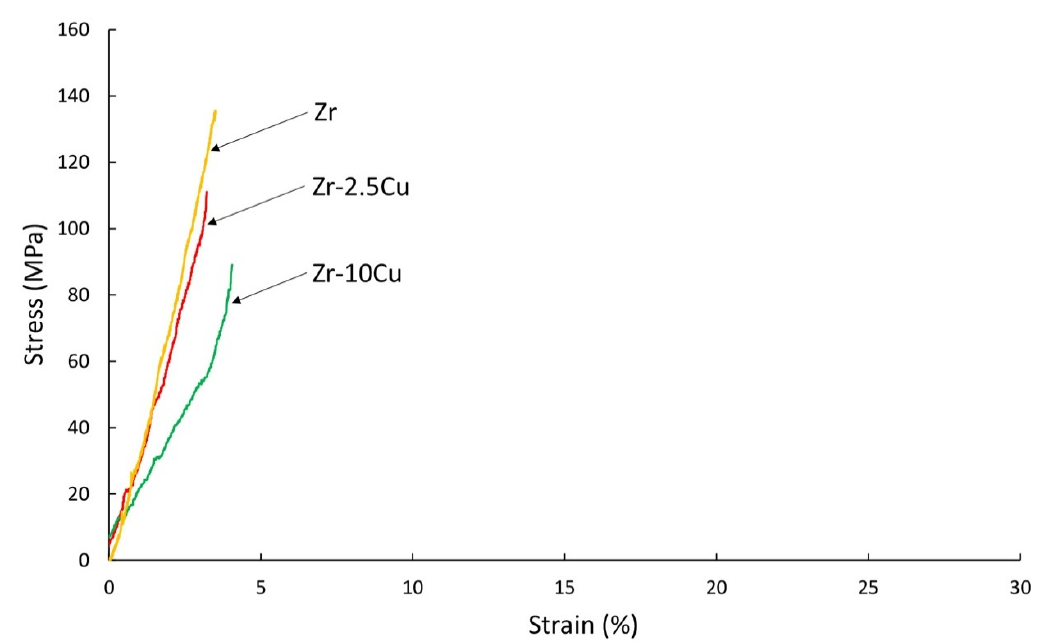
Figure 10. The results of the tensile test for the SPS samples of Zr-2.5Cu and Zr-10Cu at room temperature. For the tensile tests shown in Figure 11 at 400 ◦ C, the Zr-2.5Cu extruded materi- axis, “longitudinal”.